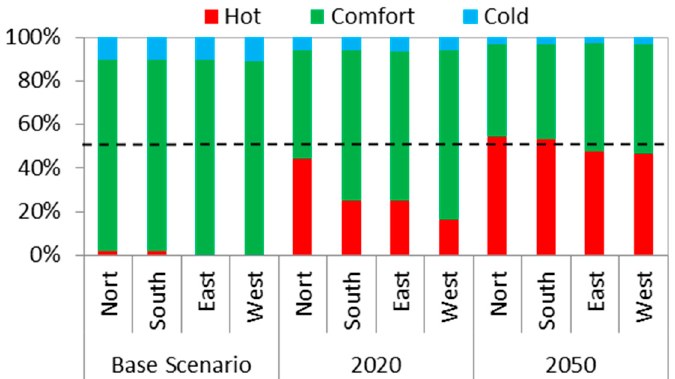
Figure 9. Weighted percentage of comfort and discomfort hours for the bedrooms inside the LIHb in the base and future